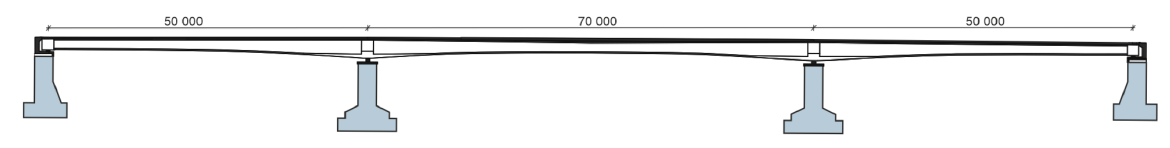
Figure 2. Longitudinal view of the Wonka